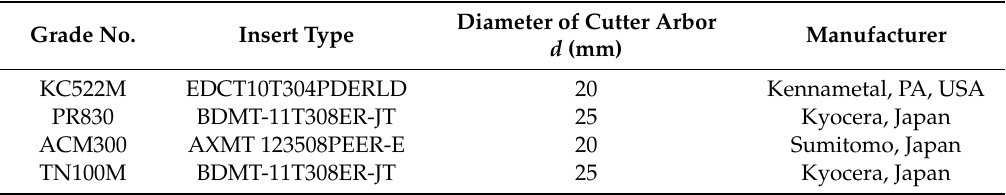
Table 2. Insert type and the diameter of cutter